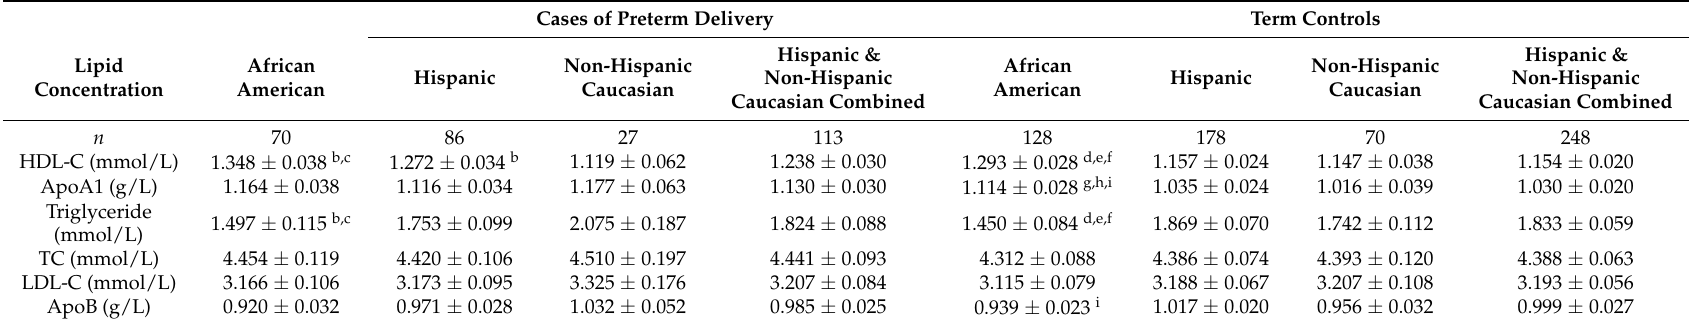
Table 3. Maternal lipid levels in spontaneous preterm delivery cases and term controls and by racial/ethnic groups a